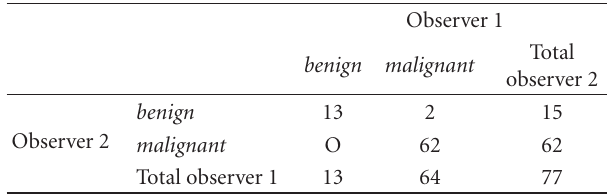
Table 3: Interobserver agreement on renal masses diagnosed malignant or benign. Observer 1 represents the primary diagnosis by general pathologists. Observer 2 represents the diagnosis as determined by the blinded review pathologists.